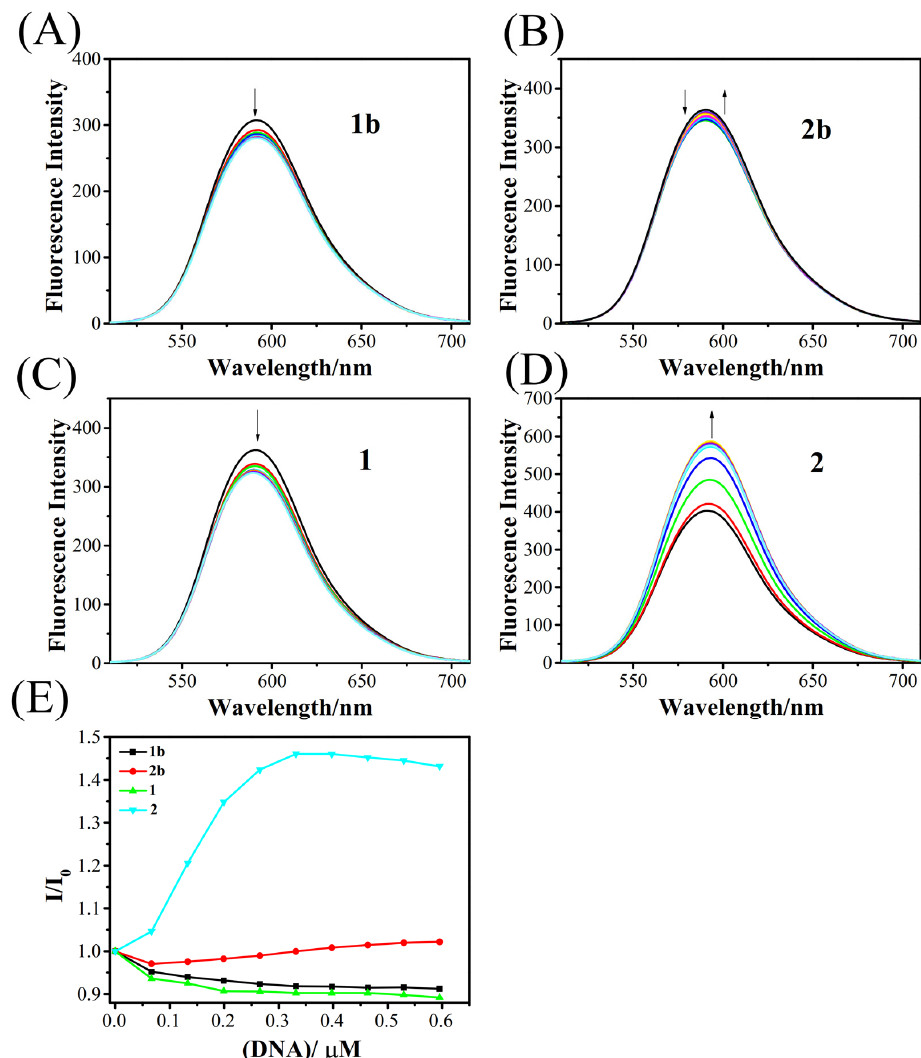
Figure 3. ( A – D ) Fluorescence emission spectra of 1b ( A ), 2b ( B ), 1 ( C ), and 2 ( D ) combined with c-myc G4 DNA in Tris-HCl-KCl buffer solution at pH 7.2. The arrow shows the change in emission intensity as the concentration of DNA increases. ( E ) The fluorescence intensity at 590 nm of 1b , 2b , 1 , and 2 with increasing concentrations of c-myc G4 DNA. ([Ru] = 10 µ M, [ c-myc ] = 0.067n, n = 0, 1, 2